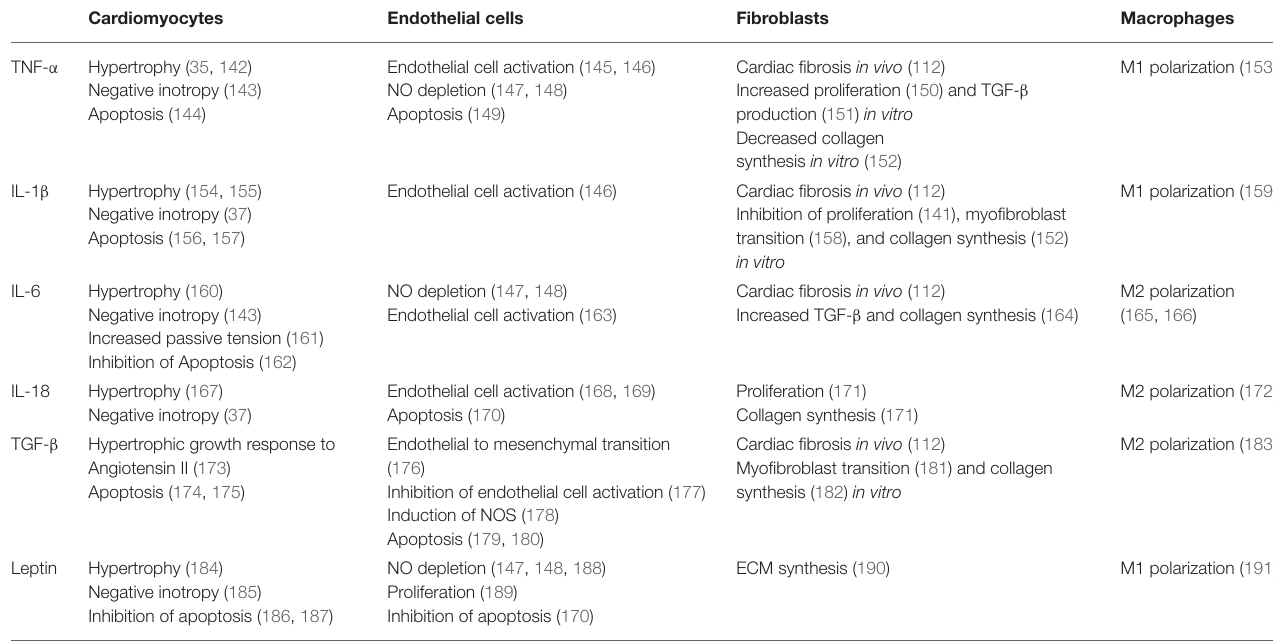
TABLE 1 | Overview of effects on different cardiac cell types mediated by selected cytokines upregulated in cardiometabolic patients.